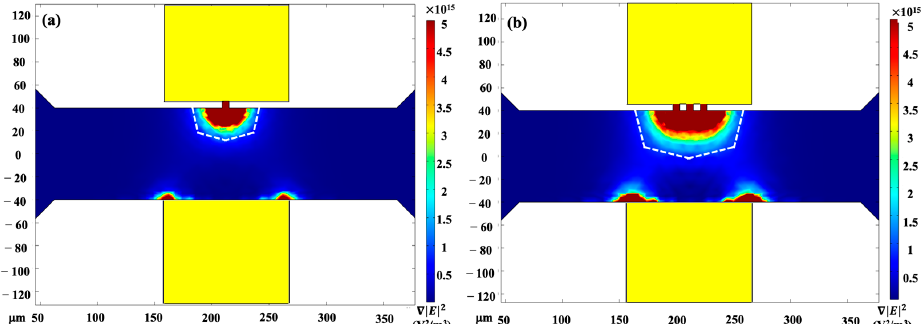
Figure 3. The numerical distribution of the electric field in the asymmetric-orifice-based microfluidic chip: ( a ) one pair and ( b ) triple pairs of asymmetric